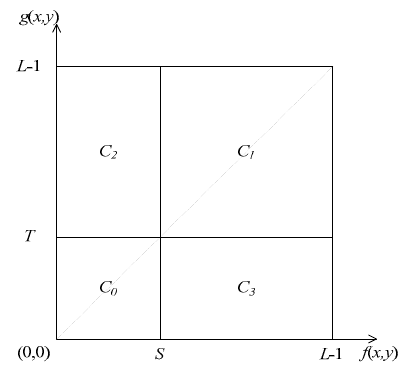
Figure 7. Diagram for threshold segmentation.